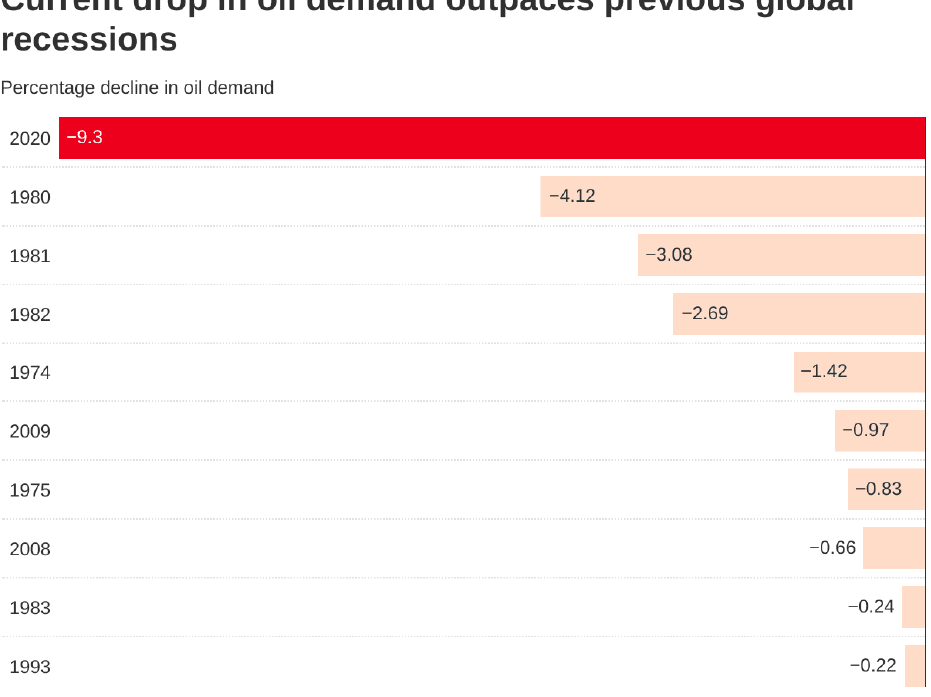
Figure 3. The worst-ever drop in oil demand due to COVID-19, World Bank [9].